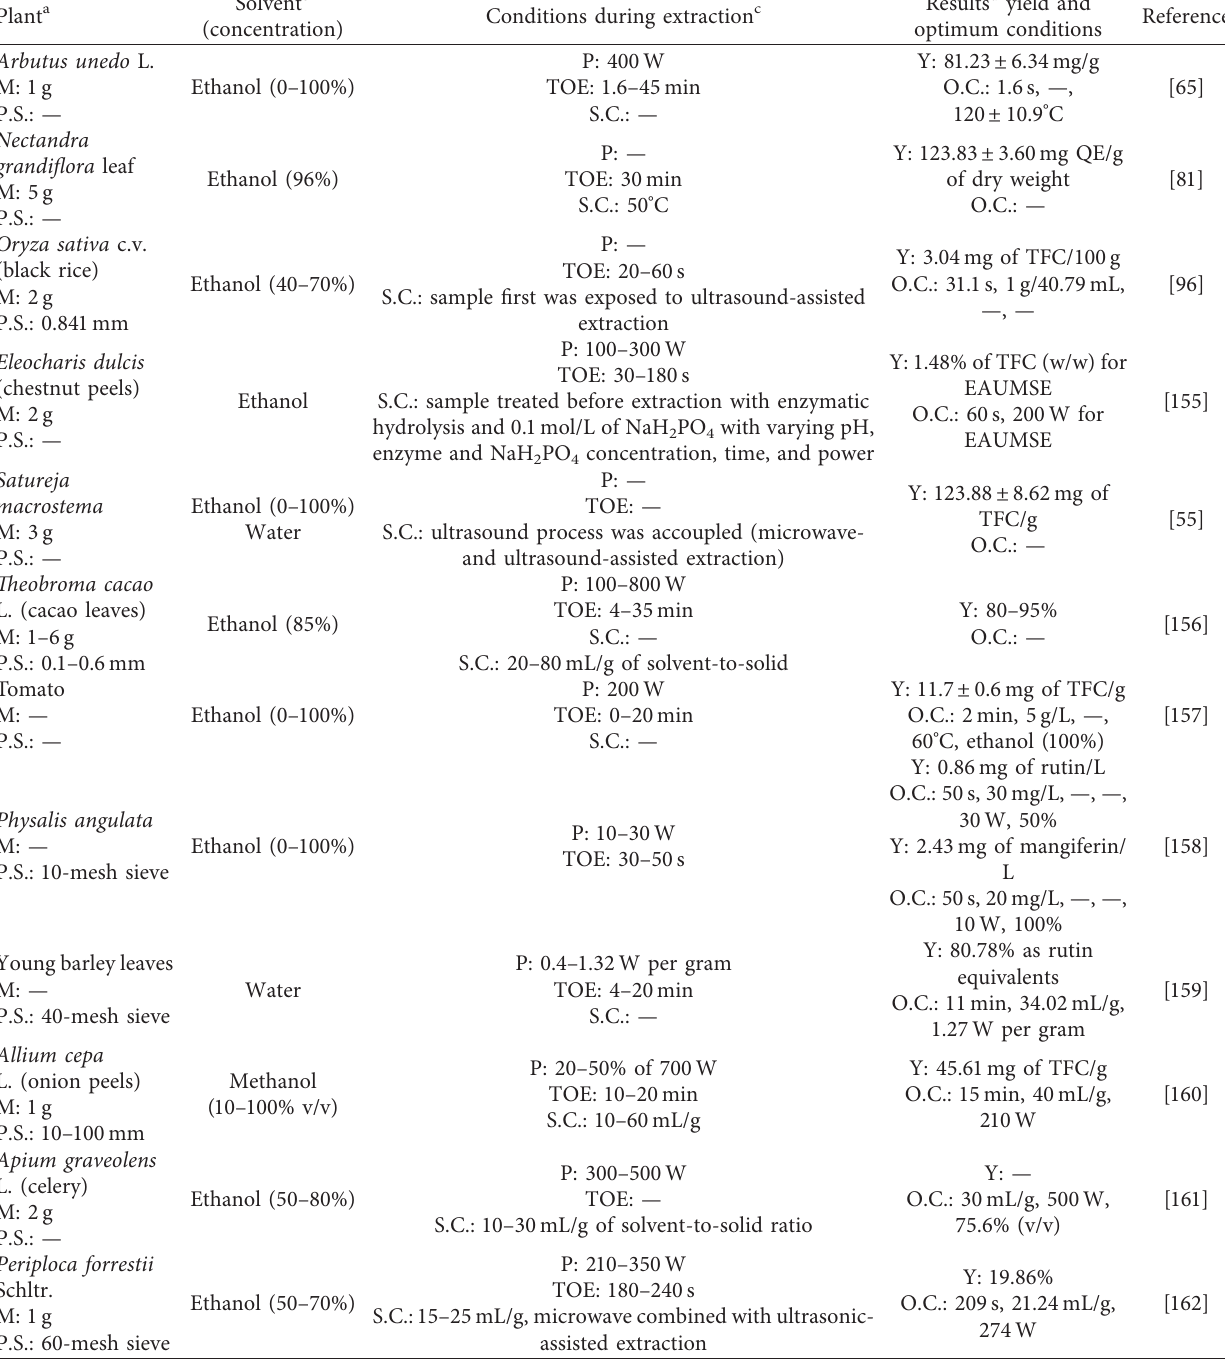
Table 5: Flavonoid sources and principal parameters and conditions in